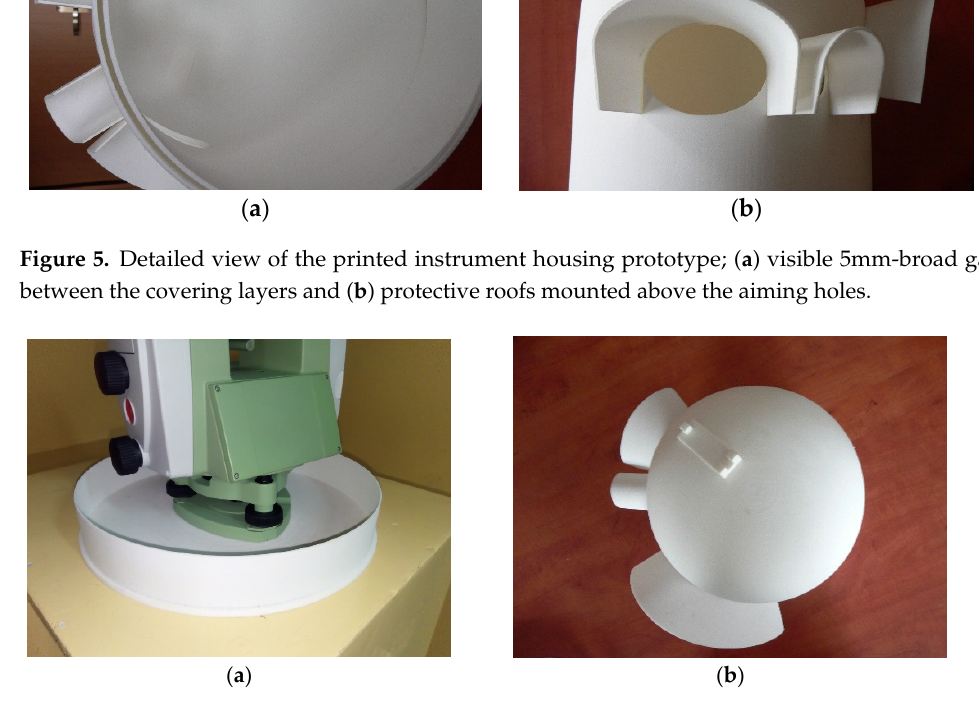
Figure 5. Detailed view of the printed instrument housing prototype; ( a ) visible 5mm-broad gap between the covering layers and ( b ) protective roofs mounted above the aiming holes.